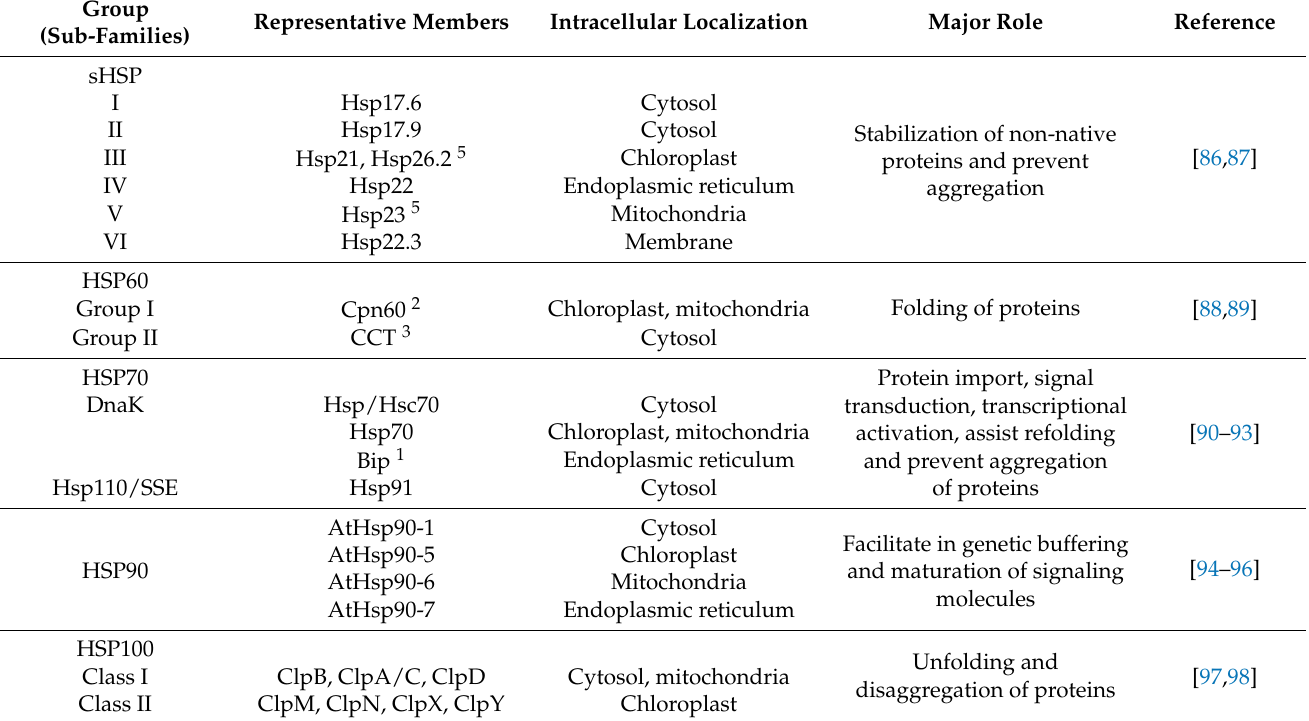
Table 1. Characterization of various groups of HSP in